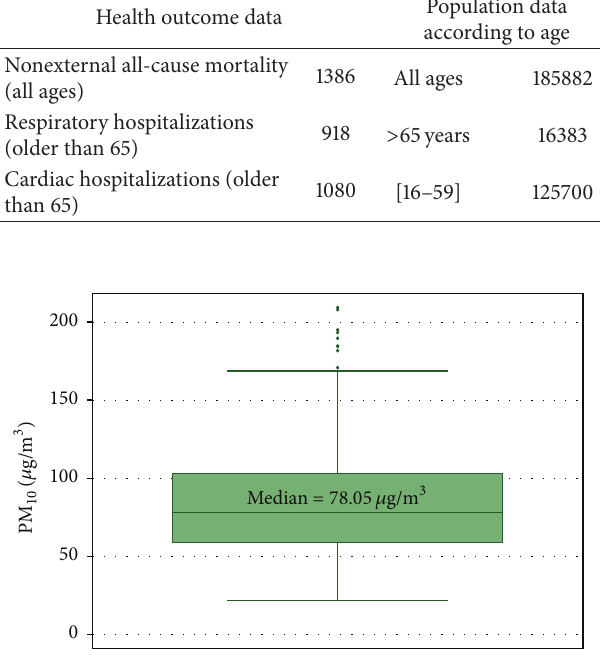
Figure 2: PM 10 concentrations in 𝜇 g/m 3 .